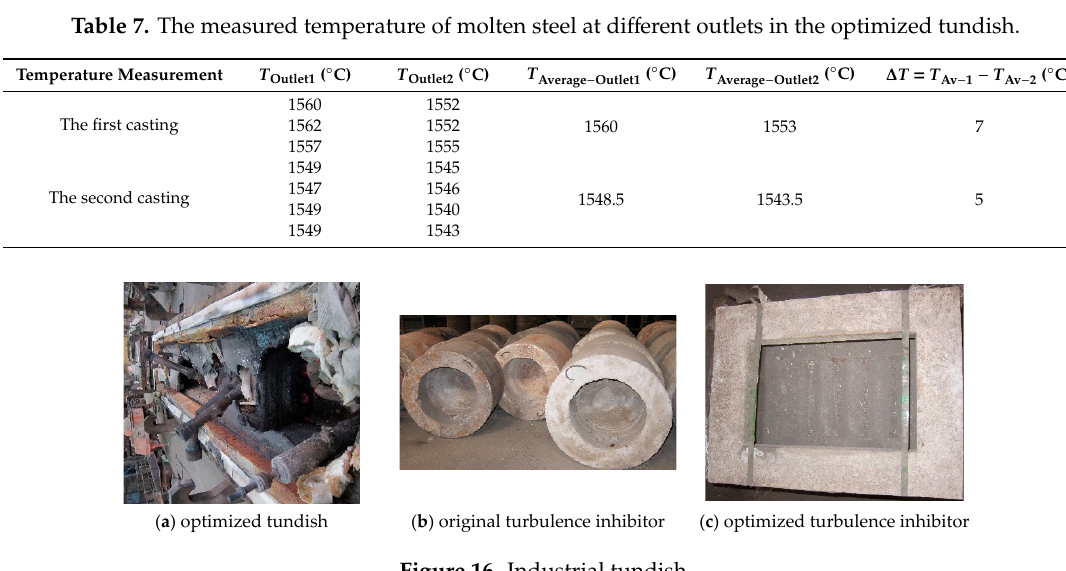
Table 6. The measured temperature of molten steel at different outlets in the original tundish. Temperature Measurement